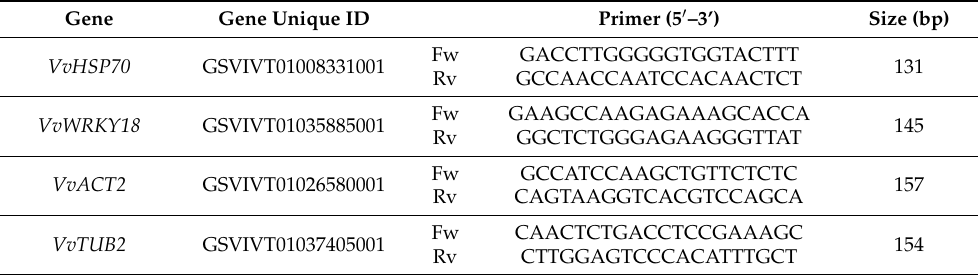
Table A1. List of Primers Used for Real-Time Quantitative